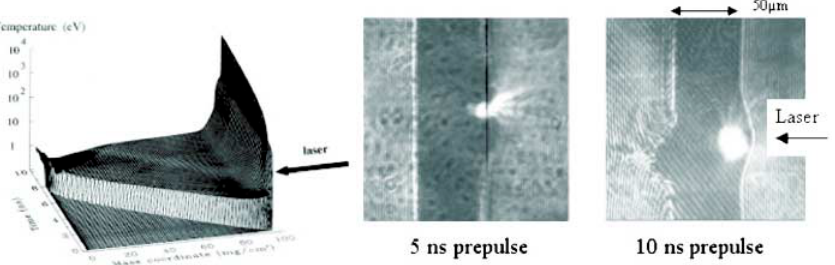
FIG. 2. Left: simulation of the shock wave launched by the prepulse. The shock wave reaches the rear surface at about 7 ns. Center: interferometric images of the plasma conditions on the front and rear target surfaces. Right: perturbation of the rear surface due to prepulse induced shock wave breakout. No protons were